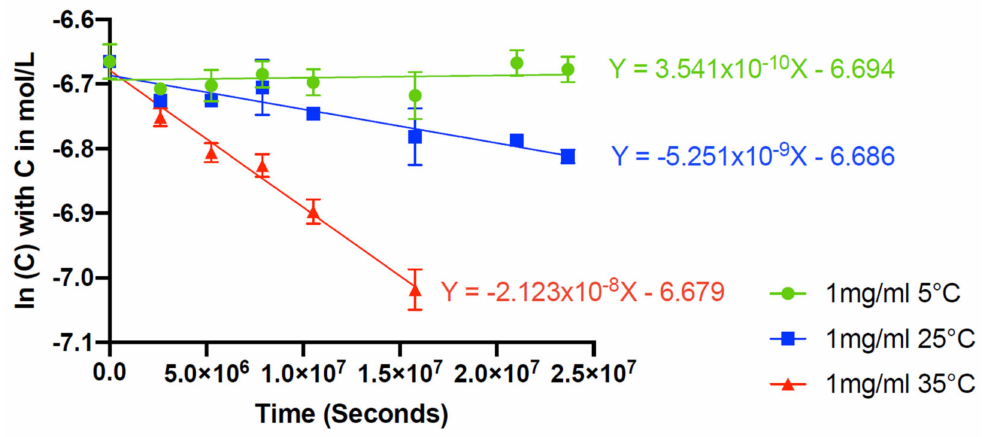
Figure 5. Graphic determination of the rate constant